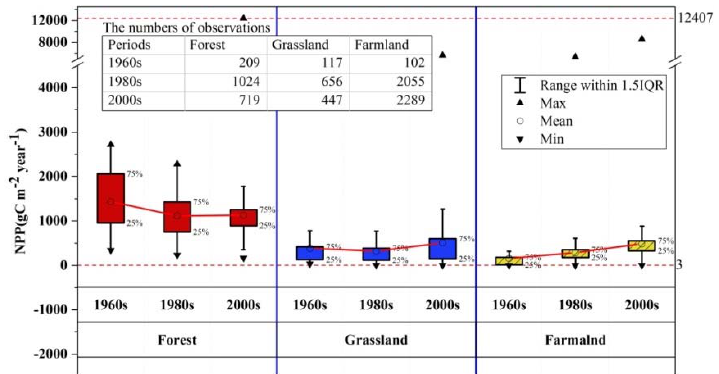
Figure 2. The statistical characteristics of sample point NPP observations.